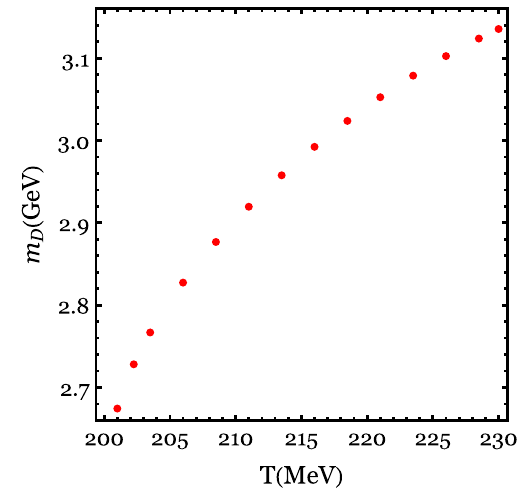
critical temperature T c . One notes that for increasing temper- ature, the plasma becomes more and more screened since m D is monotonically increasing. The model provides the values of the screening mass in the range 201MeV ≤ T ≤ 230MeV, making it possible to investigate the region near the critical temperature. An important support for the validity of the model comes from the check, in the previous section, of the T = 0 limit. The value obtained for the glueball mass is consis- tent with lattice data. Other studies of screening in a non- Abelian plasma using holography can be found, for example, in